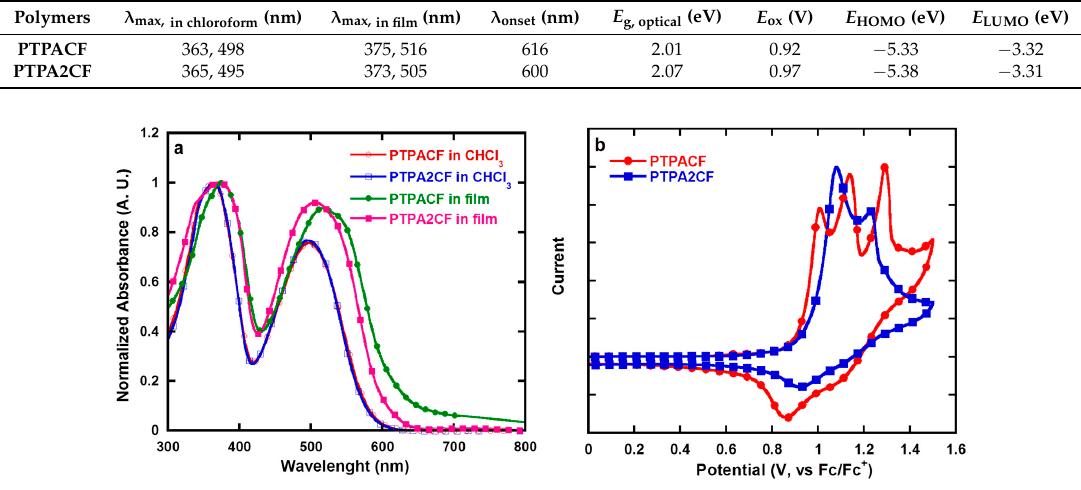
Figure 3. UV-vis absorption spectra ( a ) and cyclic voltammogram curves ( b ) of the polymers.